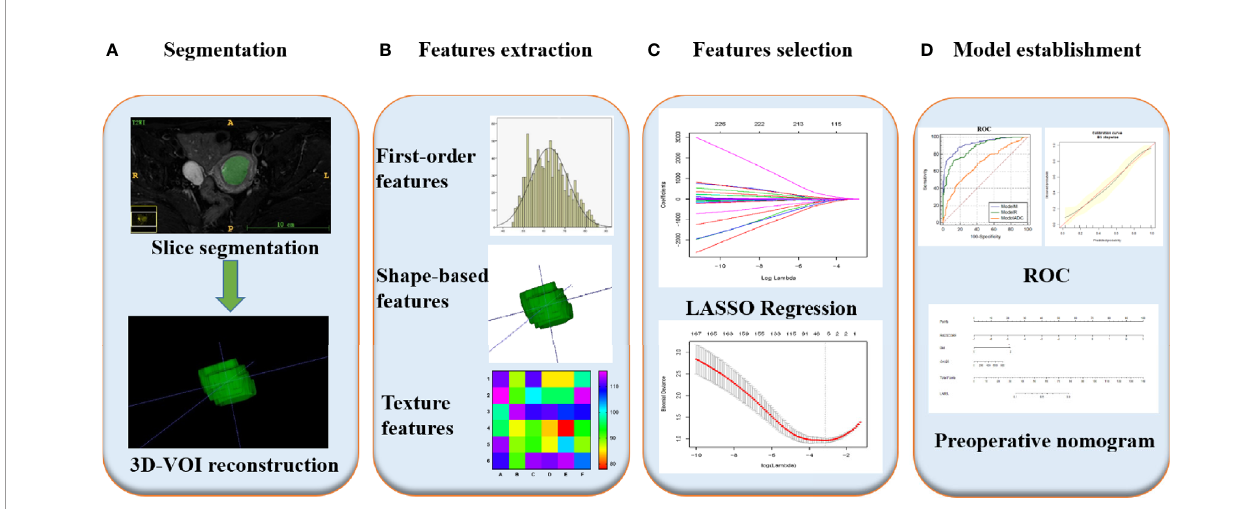
FIGURE 2 | Radiomics work fl ow of model construction. (A) MR images segmentation. First, the boundary of tumor was delineated layer by layer on each image, considering necrosis, cystic lesions and bleeding areas inside the tumor during the delineation and 3D segmented tumor images were fi nally obtained using ITK- SNAP. (B) Radiomics features extraction. According to the segmentation image, a total of 100 parameters of 6 types were extracted from each set of images. (C) Radiomics features selection. After the parameters were normalized and dimensionality reduced, the characteristic parameters were selected and classi fi ed by LASSO regression. (D) Model establishment. Combined with two clinical indicators of location and size, nomogram was developed to establish a preoperative evaluation model, and its diagnostic ef fi cacy was evaluated by ROC analysis.